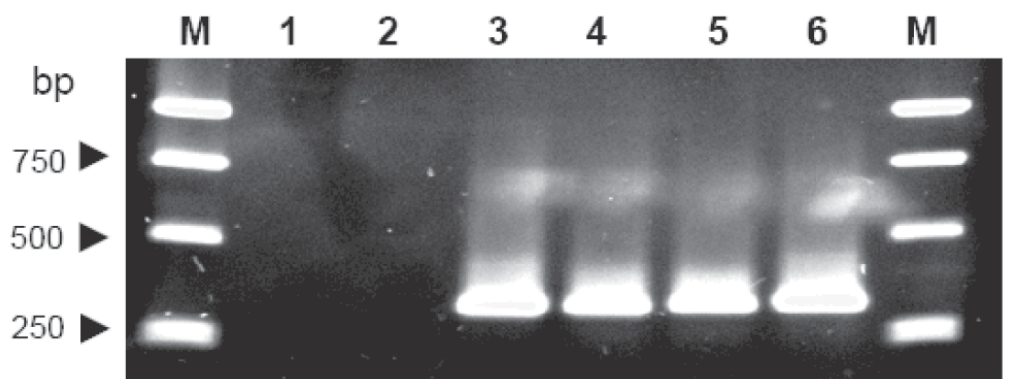
Fig. 4. PCR performed with TYLCV specific primers PTYIRv21 and PTYIRc287, using cloned full-length genomic DNA of TYLCSV from Morocco (pTYLCSV-MO-1) and TYLCV from the Dominican Republic (TYLCV-[DO]) as tem- plate. Lane 1, pTYLCSV-MO-1 (1 ng DNA); lane 2, pTYLCSV-MO-1 (0.1 ng); lane 3, TYLCV-[DO] (0.1 ng); lane 4, TYLCV-[DO] (0.01 ng); lane 5, mixture of pTYLCSV-MO-1 (1 ng) and TYLCV-[DO] (0.1 ng); lane 6, mixture of pTYLCSV-MO-1 (0.1 ng) and TYLCV-[DO] (0.01 ng); lane M, 1 Kbp ladder